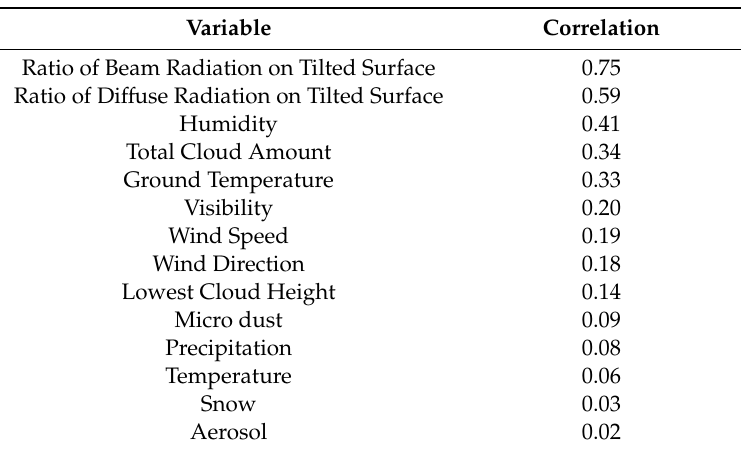
Table 4. Correlation analysis